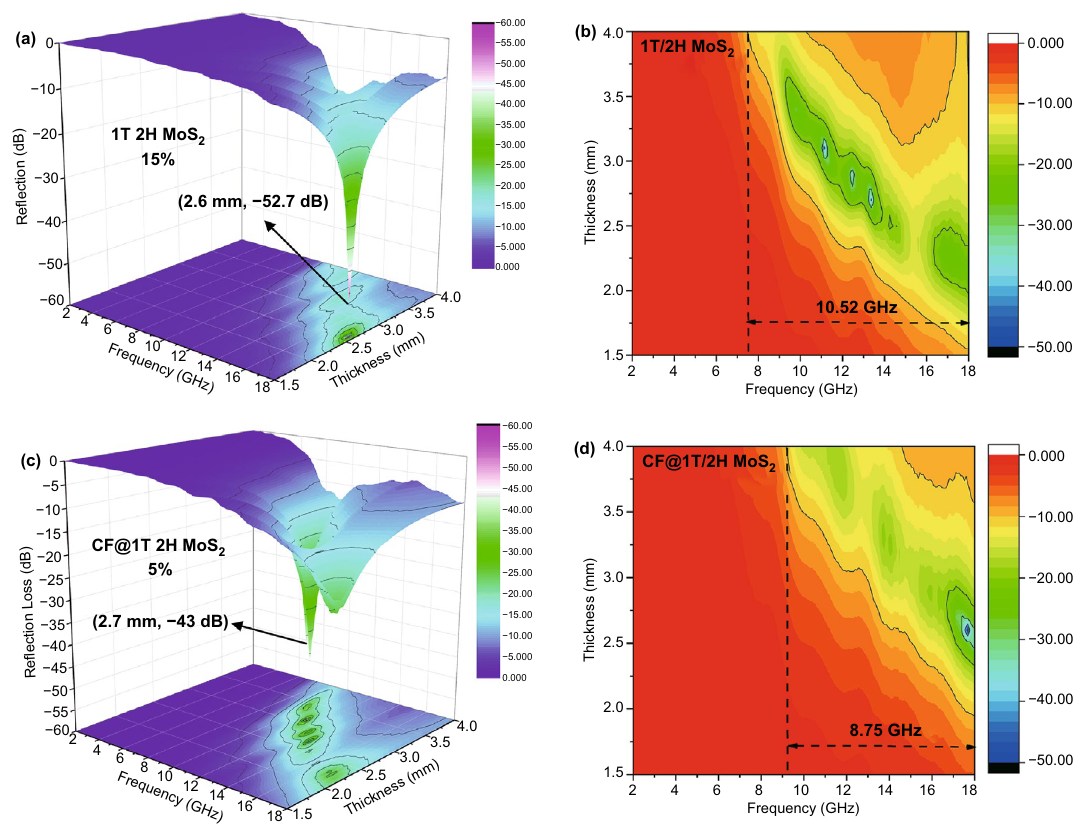
Fig. 6 a , c 3D reflection loss, b , d corresponding contour maps of 1T/2H MoS 2 (15%) and CF@1T/2H MoS 2 (5%)